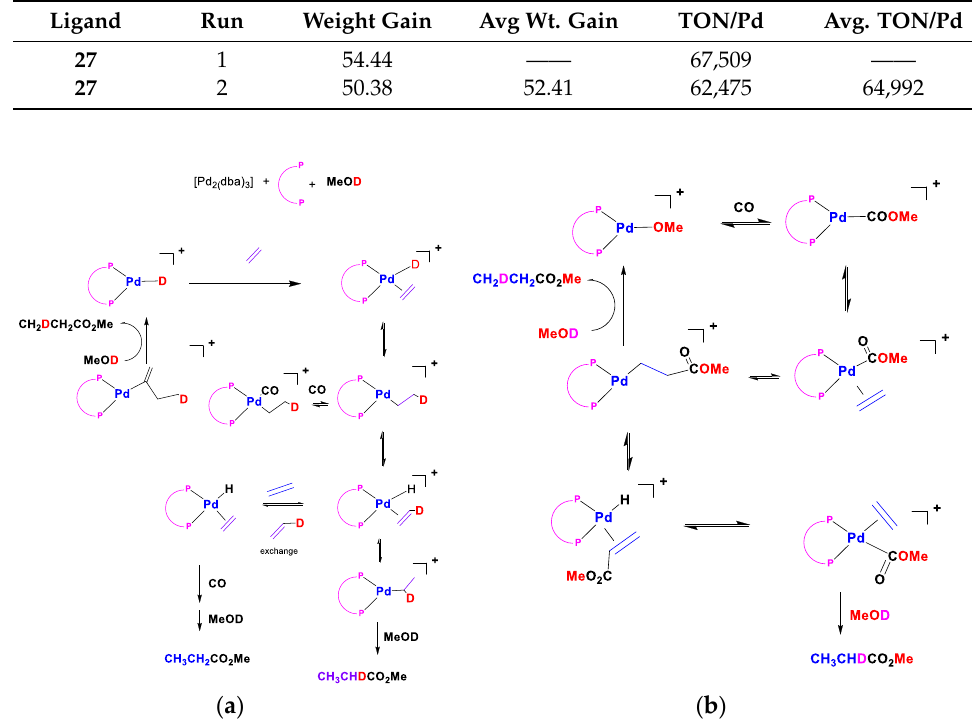
Table 6. The individual and average weight gains and catalytic testing results for the palladium dichloride complex of 1,2-di-tert-butylphosphinomethyl ruthenocene, 27 . These are the same conditions used for 2aPdCl 2 (see Table 2).